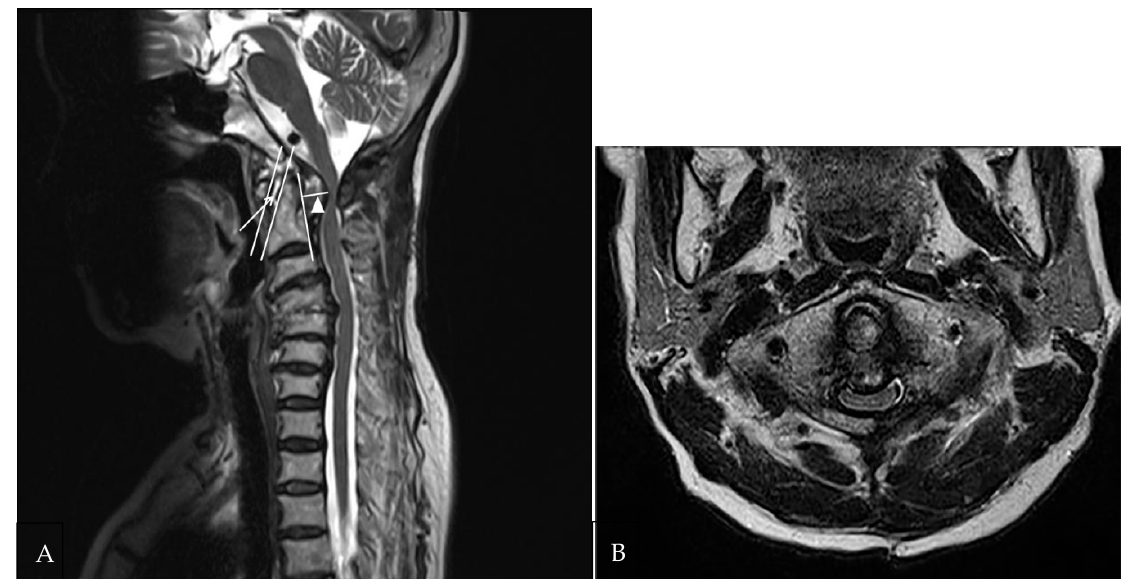
Figure 2. A 75-year-old female patient with a non-rheumatoid retro-odontoid pseudotumor. ( A ) Pre-odontoid space (arrow) was measured from the anterior arch of C1 and dense C2 on a sagittal T2WI. The retro-odontoid space (arrowhead) was measured from the posterior cortex of the odontoid process to the protrusion of the hypertrophied soft tissue lesion. ( B ) The spinal cord is compressed due to hypertrophy of retro-odontoid soft tissue. The high signal intensity inside the cord suggests compressive myelopathy on axial T2WI.